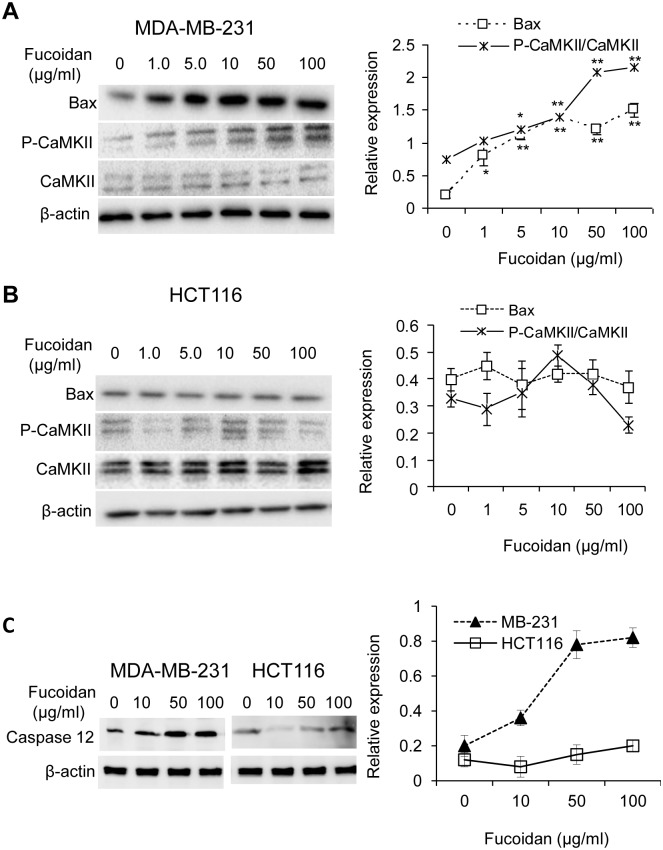
Effect of fucoidan on the relative phosphorylation of CaMKII (p-CaMKII/CaMKII) and Bax expression in MDA-MB-231 cells (A) and HCT116 cells (B).(A) Relative phosphorylation of CaMKII and Bax expression were progressively increased by fucoidan in MDA-MB-231 cells; (B) Relative phosphorylation of CaMKII was moderately stimulated (∼1.5-fold) at 10 µg/ml, followed by inhibition (∼1.4-fold) of fucoidan at 100 µg/ml. Bax expression was not affected by fucoidan in HCT116 cells. (C) Caspase 12 expression and cleavage. Fucoidan efficiently induces caspase 12 expression in MDA-MB-231 cells, rather than in HCT116 cells. No cleavage of caspase 12 was found in both types of cells. Data represent mean ± SD from triplicate experiments. *p<0.05; **p<0.01.